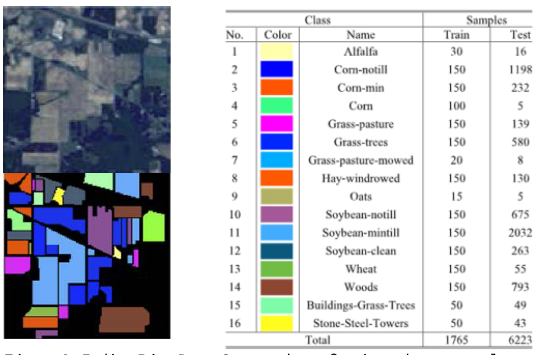
Figure 3: Indian Pine Data Set number of train and test samples